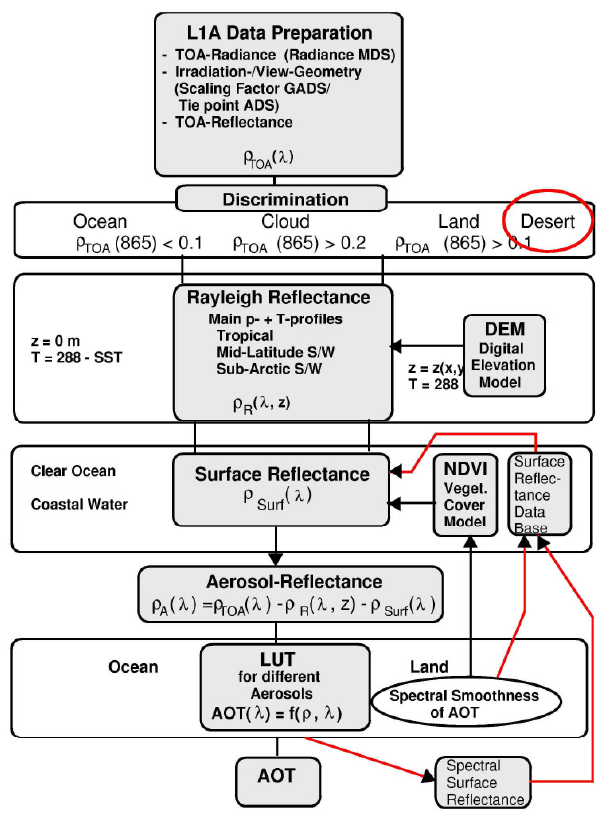
Fig. 2. Scheme of the main steps of BAER and its interactions.